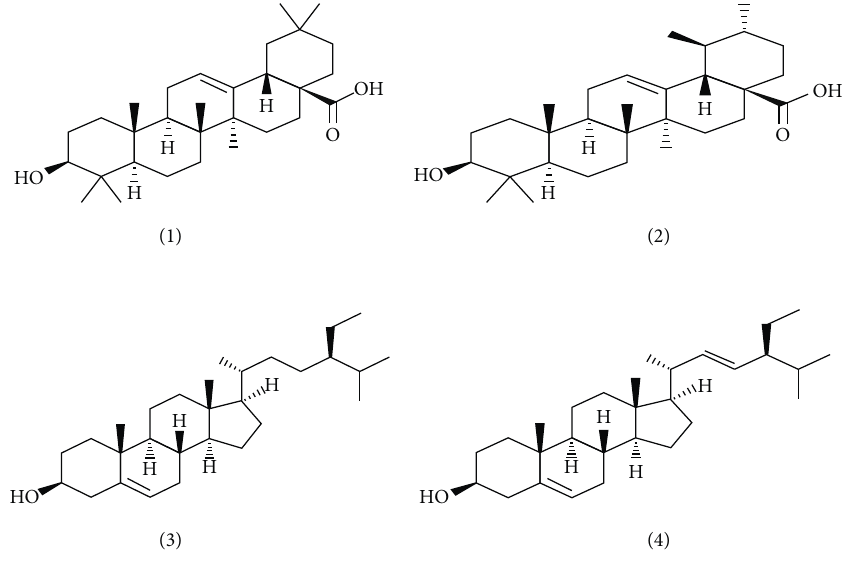
Figure 1: Structures of isolated compounds